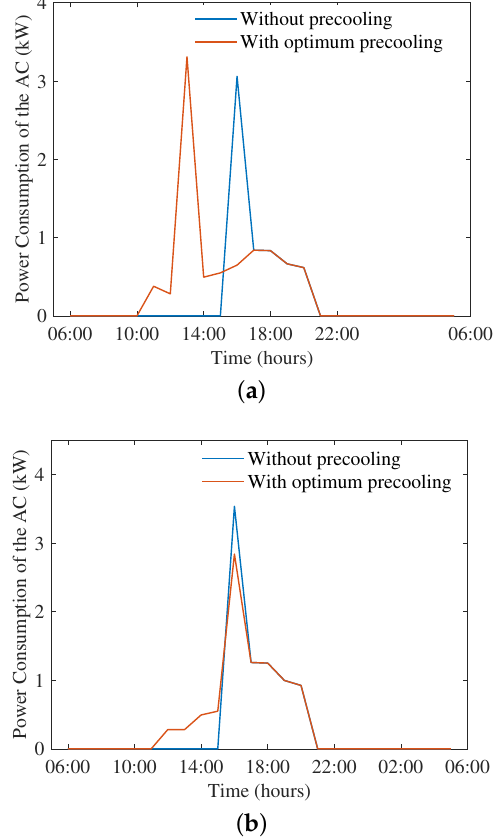
Figure 7. Impact of thermal resistance on the power consumption of the AC with and without optimum pre-cooling. ( a ) Thermal resistance = 2.3974 × 10 − 6 . ( b ) Thermal resistance = 1.5982 × 10 − 6